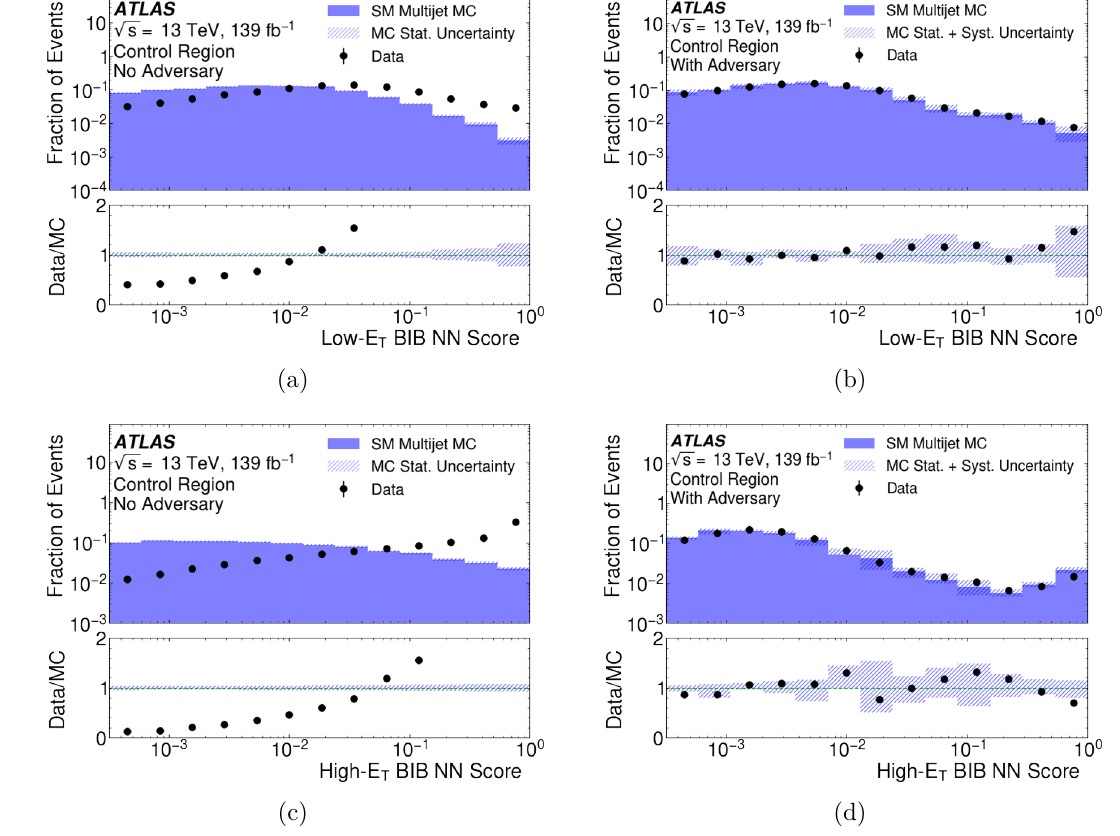
Figure 5. The NN output scores in the dijet control region for (a) the low- E T training with no adversary network and (b) with an adversary network included, (c) for the high- E T training with no adversary network and (d) with an adversary network included. Statistical uncertainties are shown in all plots. In cases where training with adversary networks is considered, the systematic uncertainty related to modelling discrepancies is included as